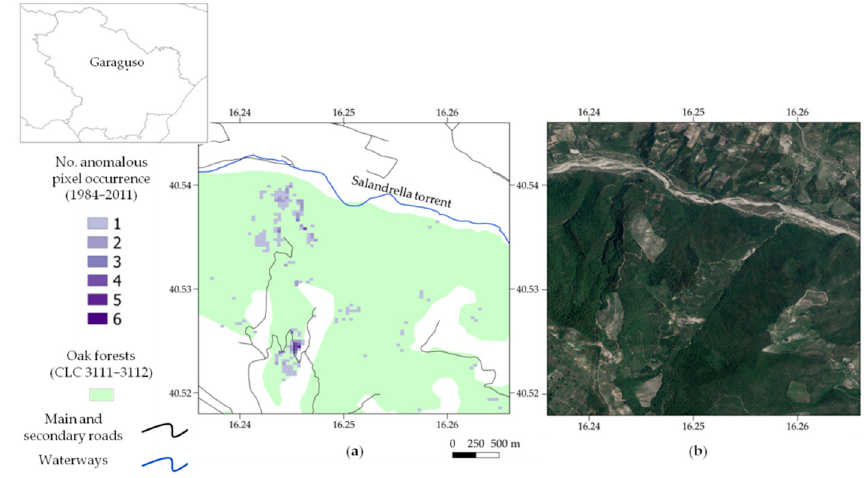
Figure 11. ( a ) Spatial distribution of anomalous (i.e., ⨂ NDVI_MVC ( x , y , t ′ ) ≤ − 3) value occurrences, from 1984 to 2011, in the oak forests in Garaguso and ( b ) orthophoto of May 2011 for comparison [46].